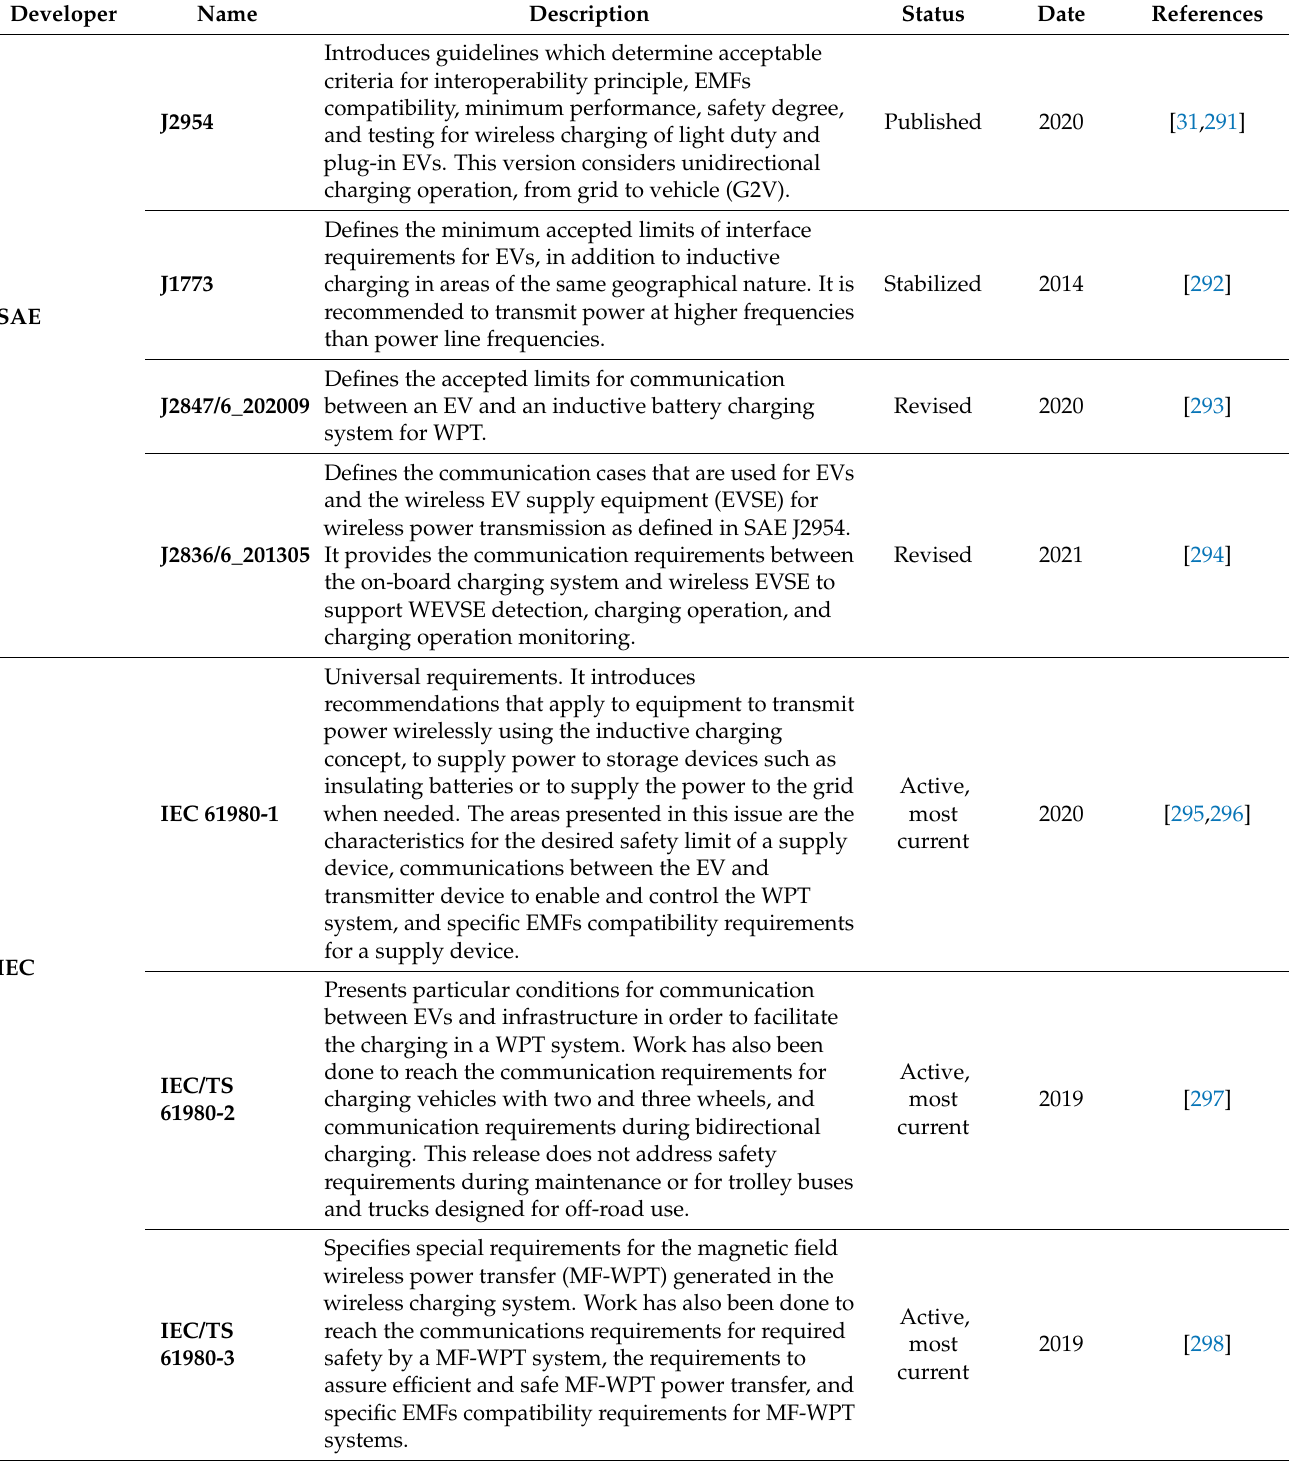
Table 16. Summary for the different standards of EV inductive stationary